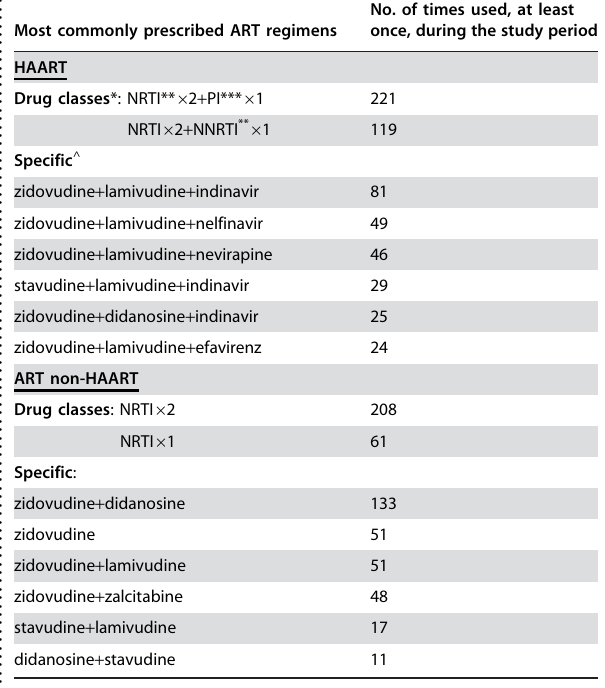
Table 2. List of the most commonly prescribed classes of and specific antiretroviral agents and their combinations used in HAART and ART non-HAART ART regimens among patients attending public HIV treatment facilities in Brazil (n=